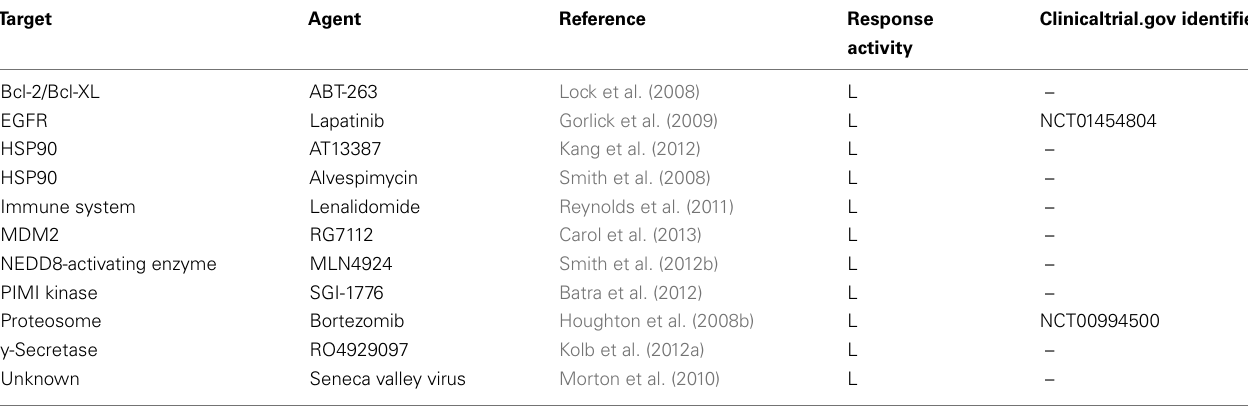
Table 2 |Agents tested by the PPTP with low activity (L) in osteosarcoma xenografts and corresponding clinical trials that include pediatric patients with